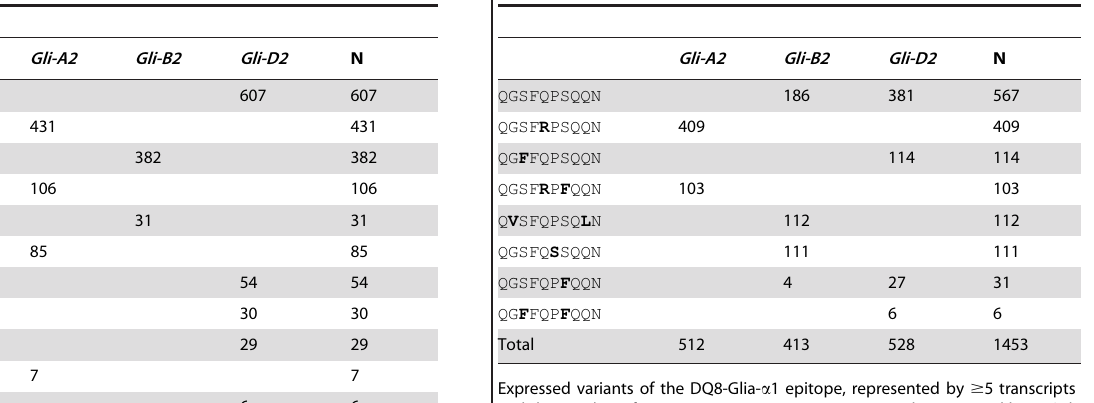
Table 3. DQ2-Glia- a 2 epitope variants expressed in bread wheat.